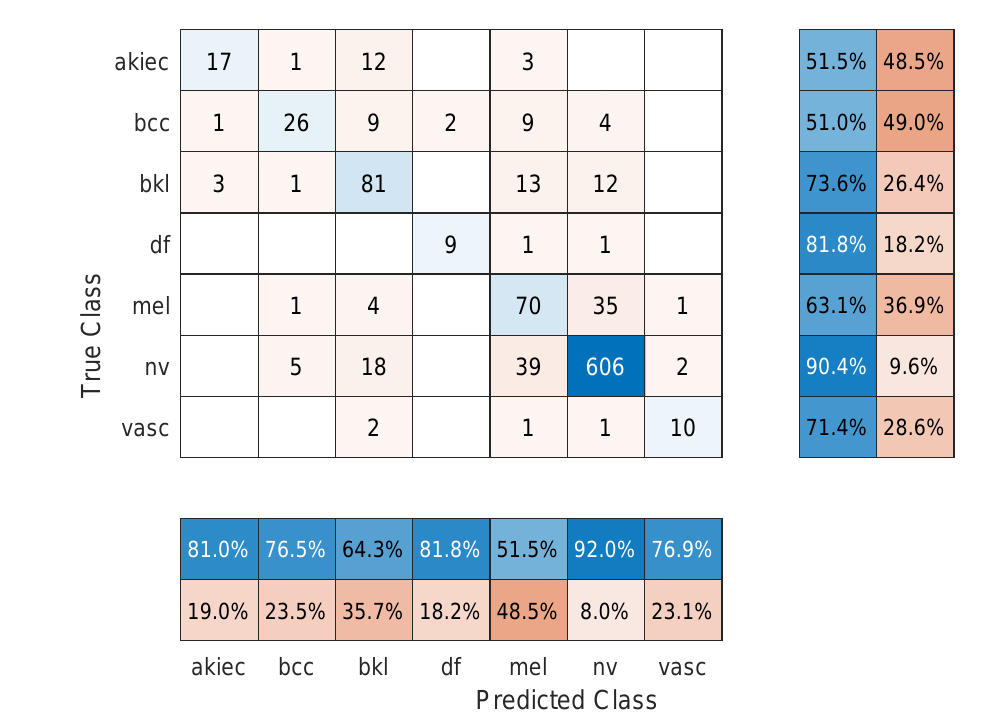
Figure 6. Sample confusion matrix for DarkNet-53 model and 90/10 data split.